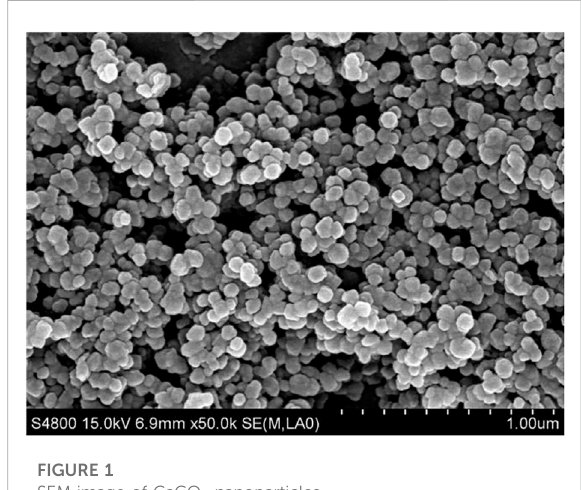
FIGURE 1 SEM image of CaCO 3